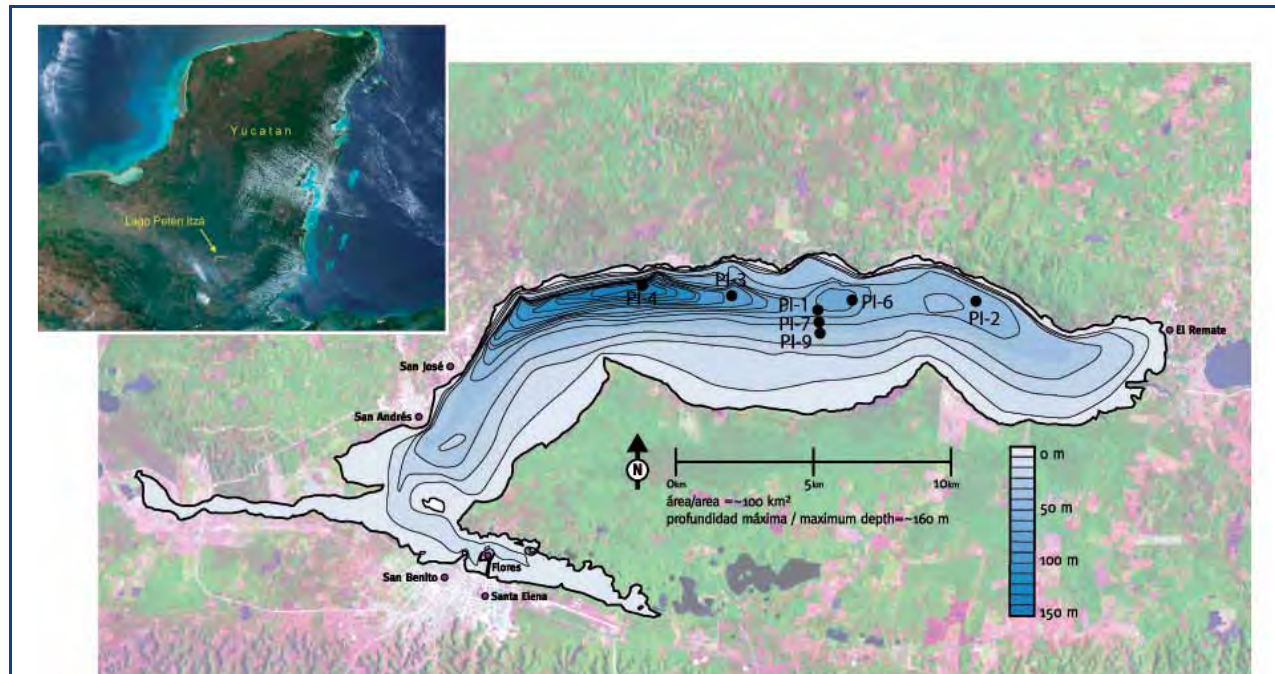
Figure 1. Inset satellite image shows location of Lake Petén Itzá on Yucatan Peninsula. Bathymetric map shows location of drilling sites